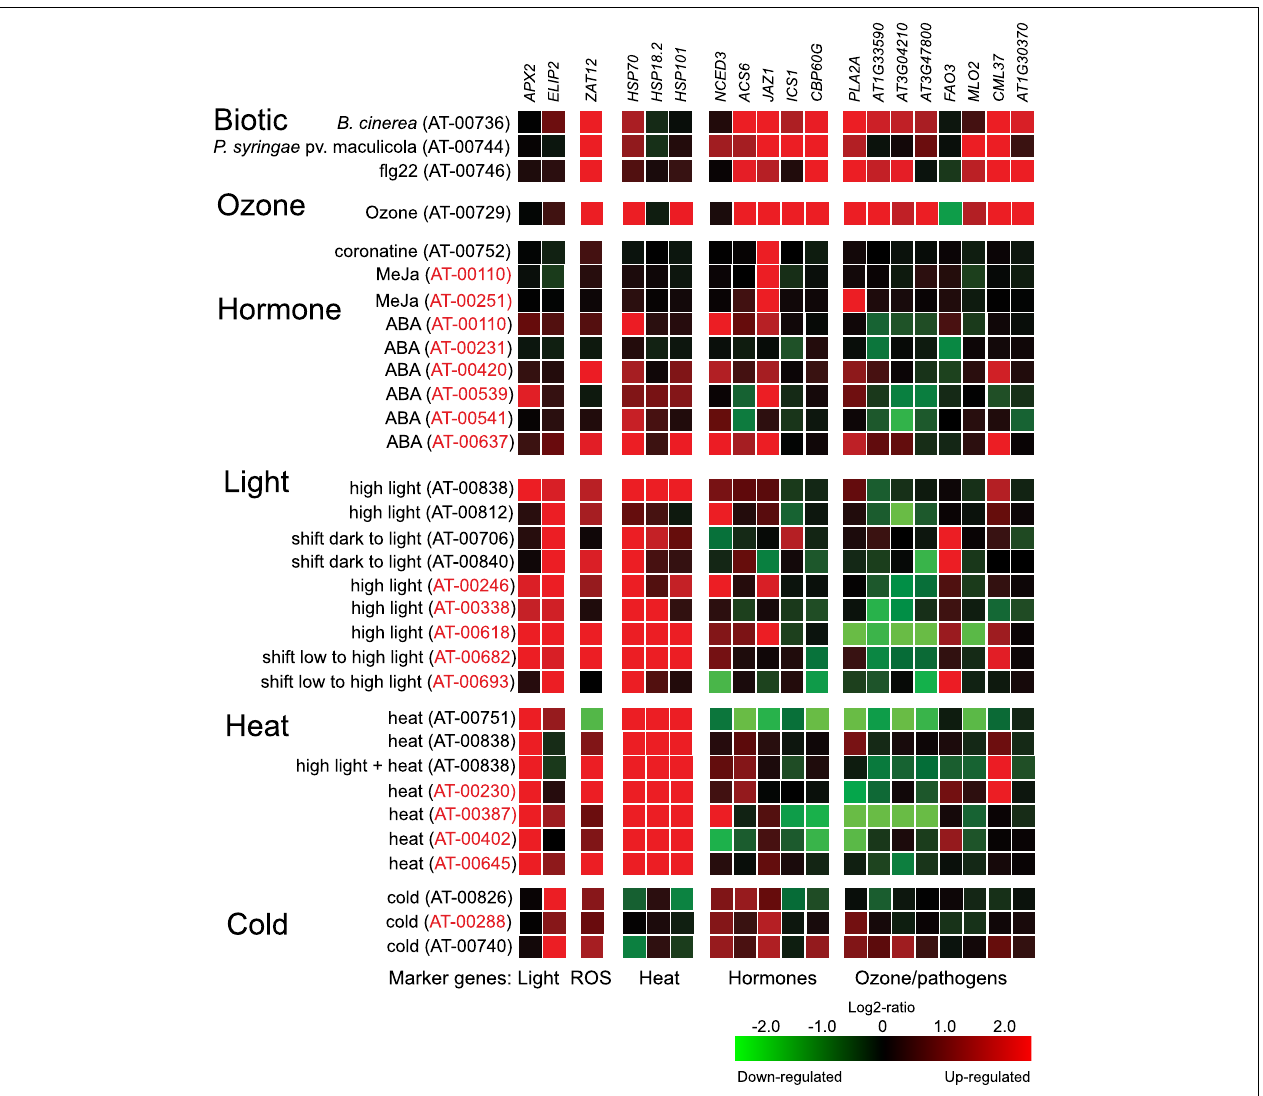
FIGURE 1 | Expression of marker genes in publicly available transcriptome data. Experiments from the Genevestigator perturbation tool were selected to include O 3 , HL, heat, cold, hormones, and biotic stress treatments. The identification number for each experiment refers to the identifier in the Genevestigator database. Samples with identifiers in red comes from Affymetrix ATH1 array and in black from RNA-seq experiments.